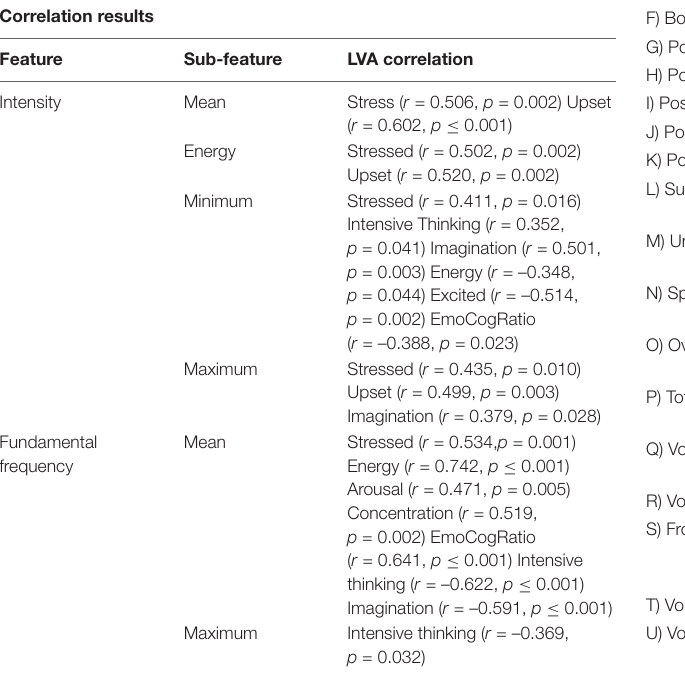
TABLE 2 | Correlation results between Nemesysco Ltd and a commonly used open source software.